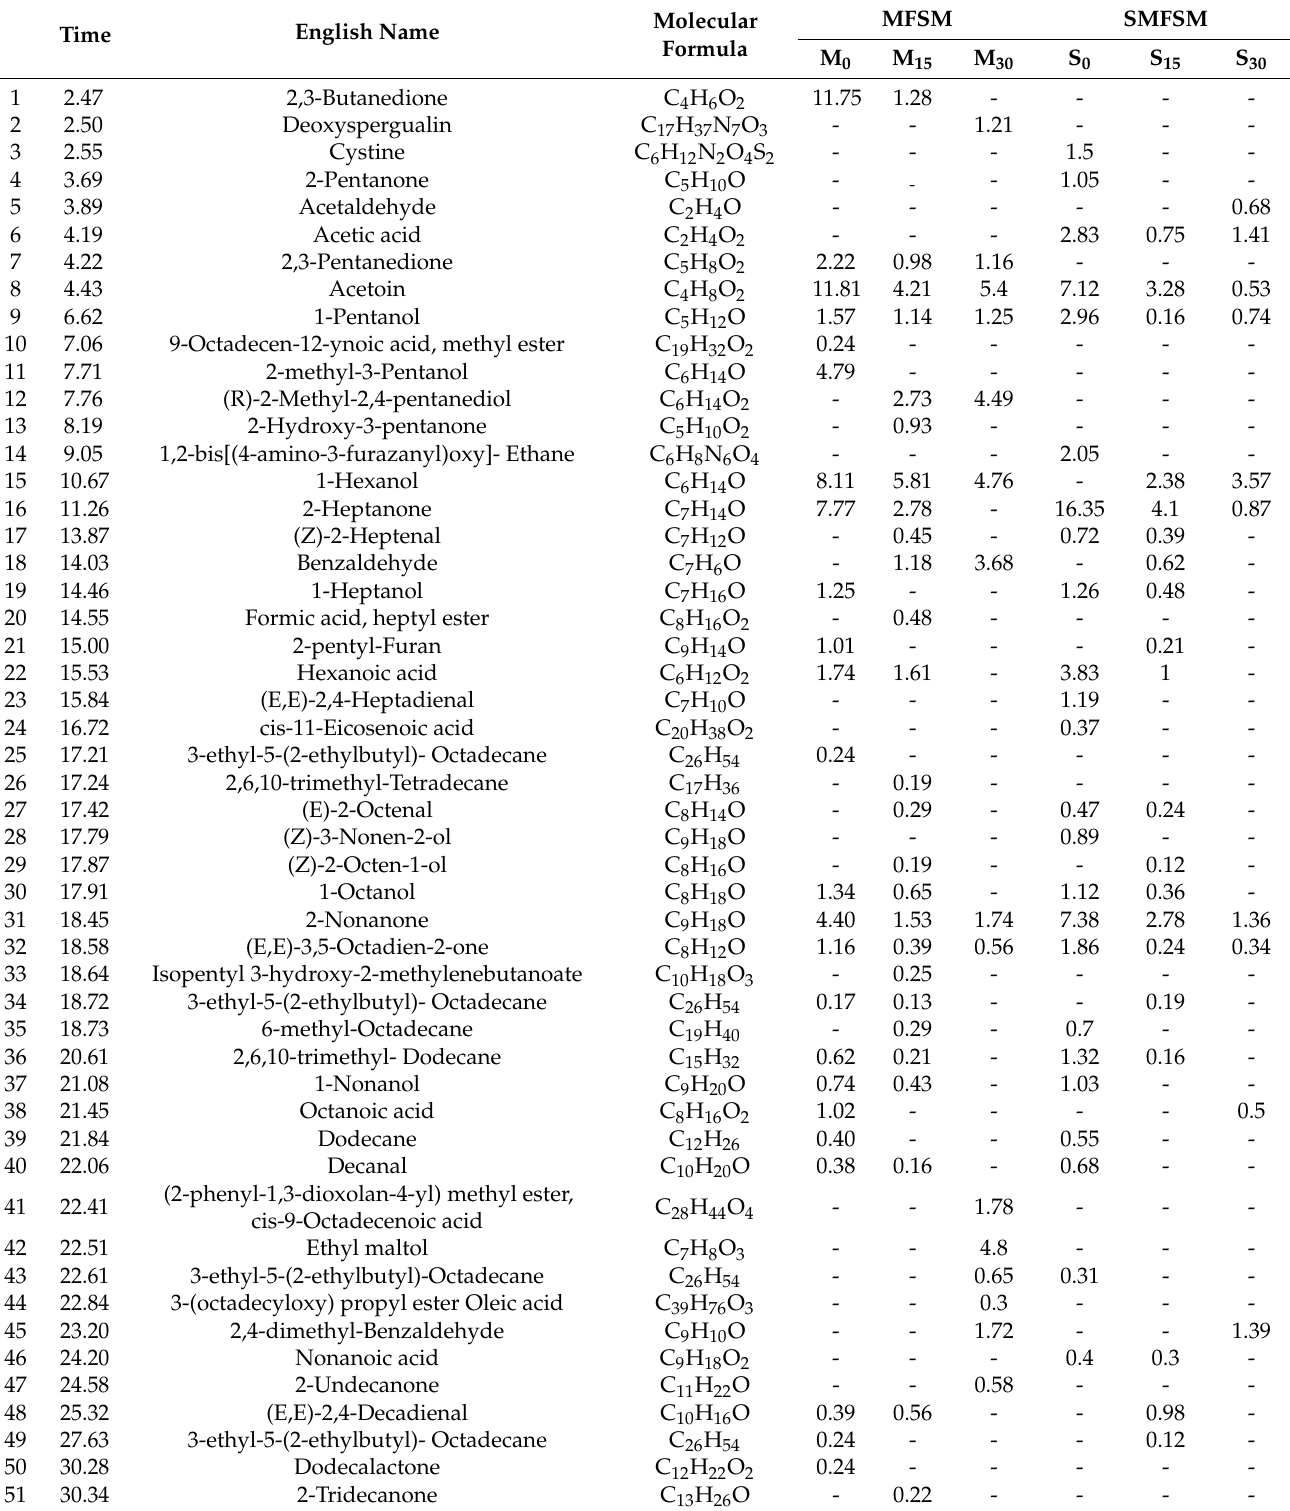
Table 1. Effect of different mixed fermentation methods on the volatile flavors of fermented soymilk during